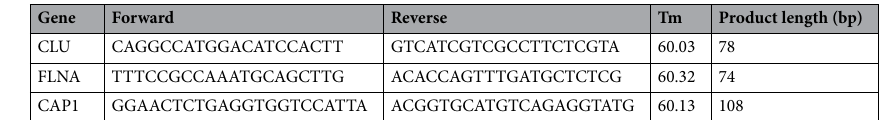
Table 5. Details of forward and reverse primer sequences of three candidated genes used for qRT-PCR